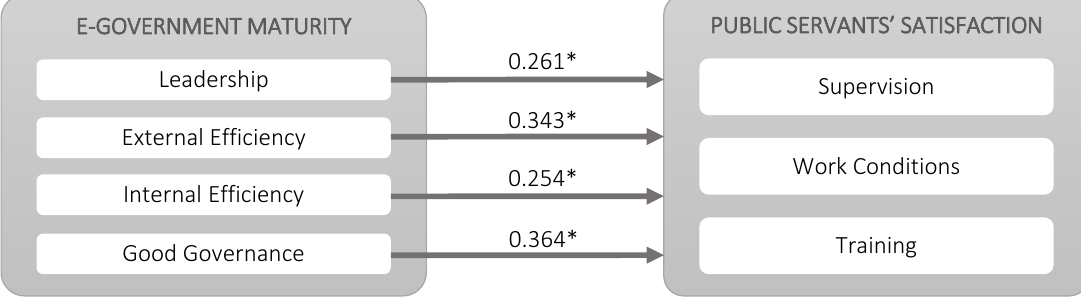
Figure 1. Hypotheses testing